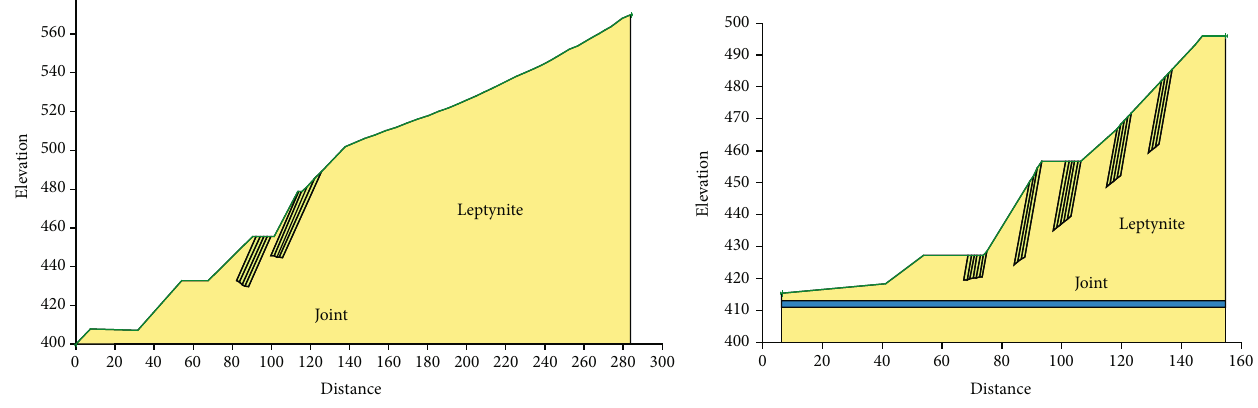
Figure 7: Section 1-1 and section 4-4 model diagram. Table 2: Calculation parameters of the slope seepage